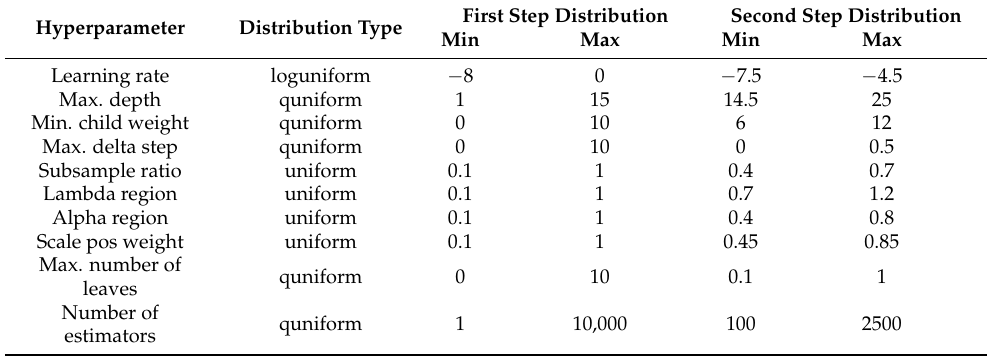
Table 1. Hyperparameter distributions.